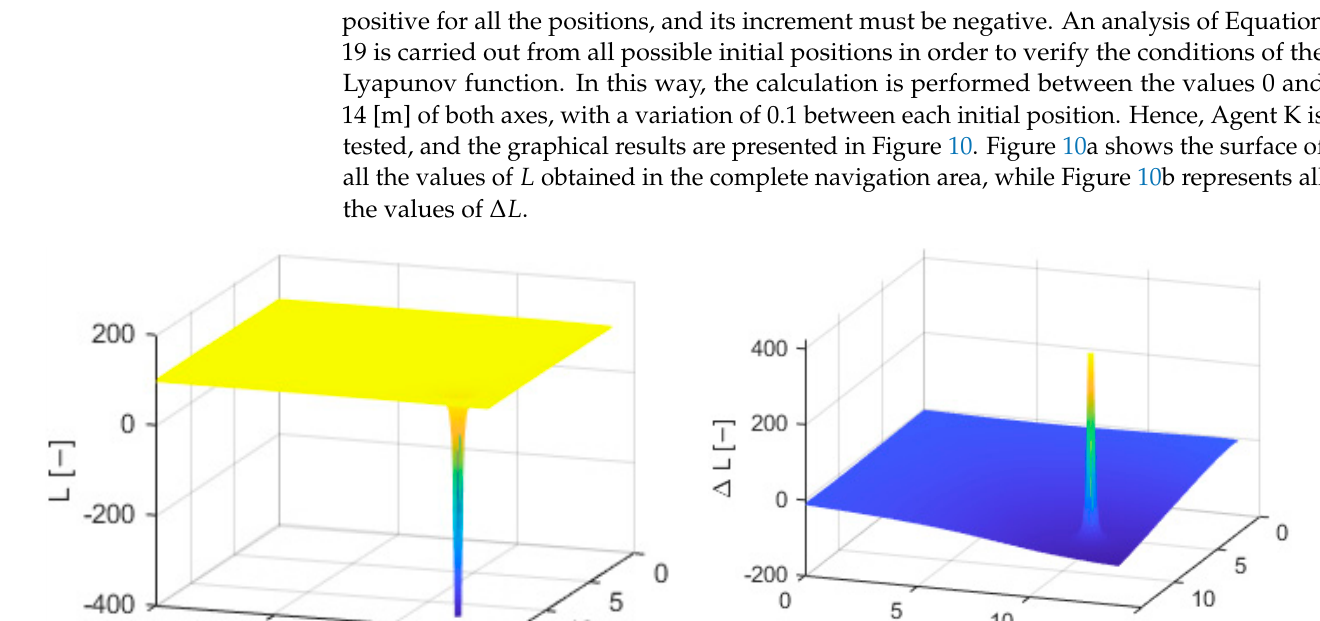
Figure 11. Enlargement of the region of interest of the results of the Lyapunov function 𝐿 in the whole navigation area for Agent K.